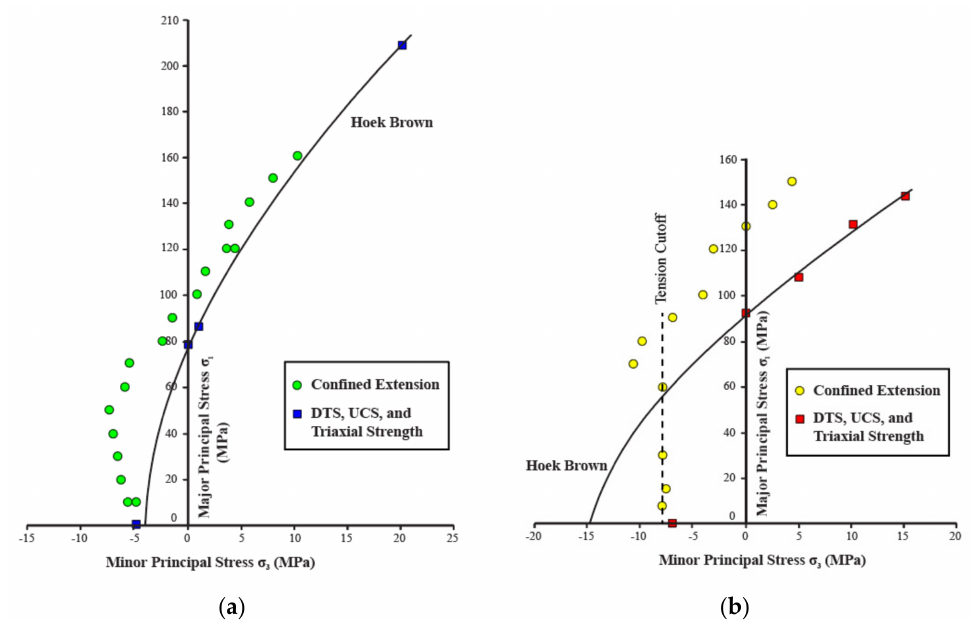
Figure 2. Strength data for ( a ) Berea Sandstone [10] and ( b ) Carrara Marble [1]. Results include confined extension tests, as well as direct tension (DTS), uniaxial compression (UCS) and triaxial tests. The Hoek Brown failure criteria is shown for the confined extension tests, as well as the tension cut off. Modified from Hoek and Martin [6] and Patel and Martin